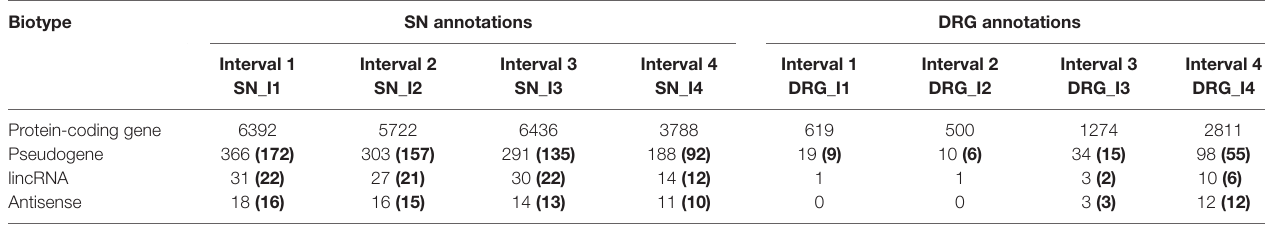
TaBle 1 | classification of bioentities (source: ensembl) – combined gene annotations for differentially expressed bioentities at different time points for the two tissues (sn, Drg).